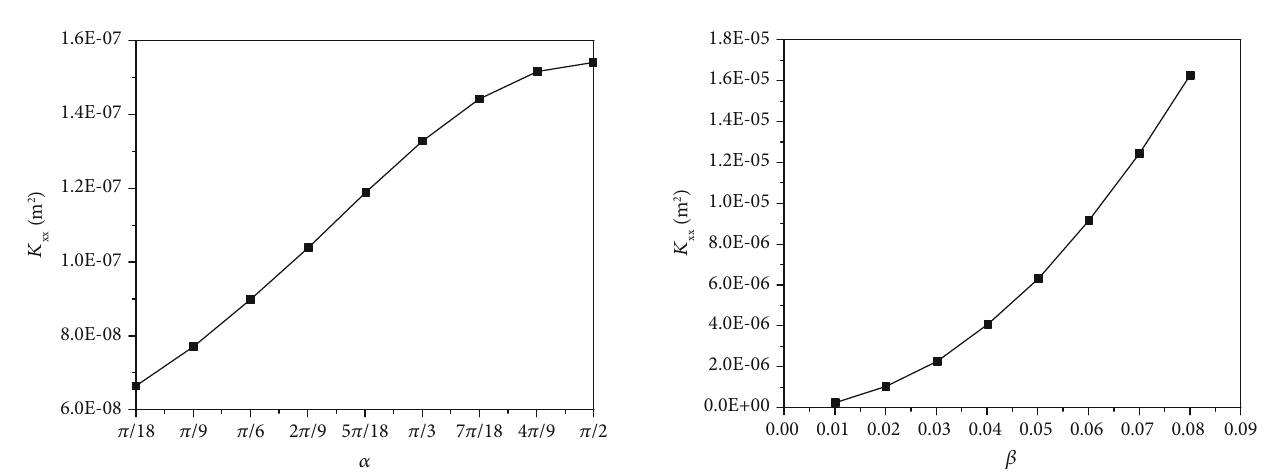
( D = 1 : 4 , D = 1 : 01 , xx f T